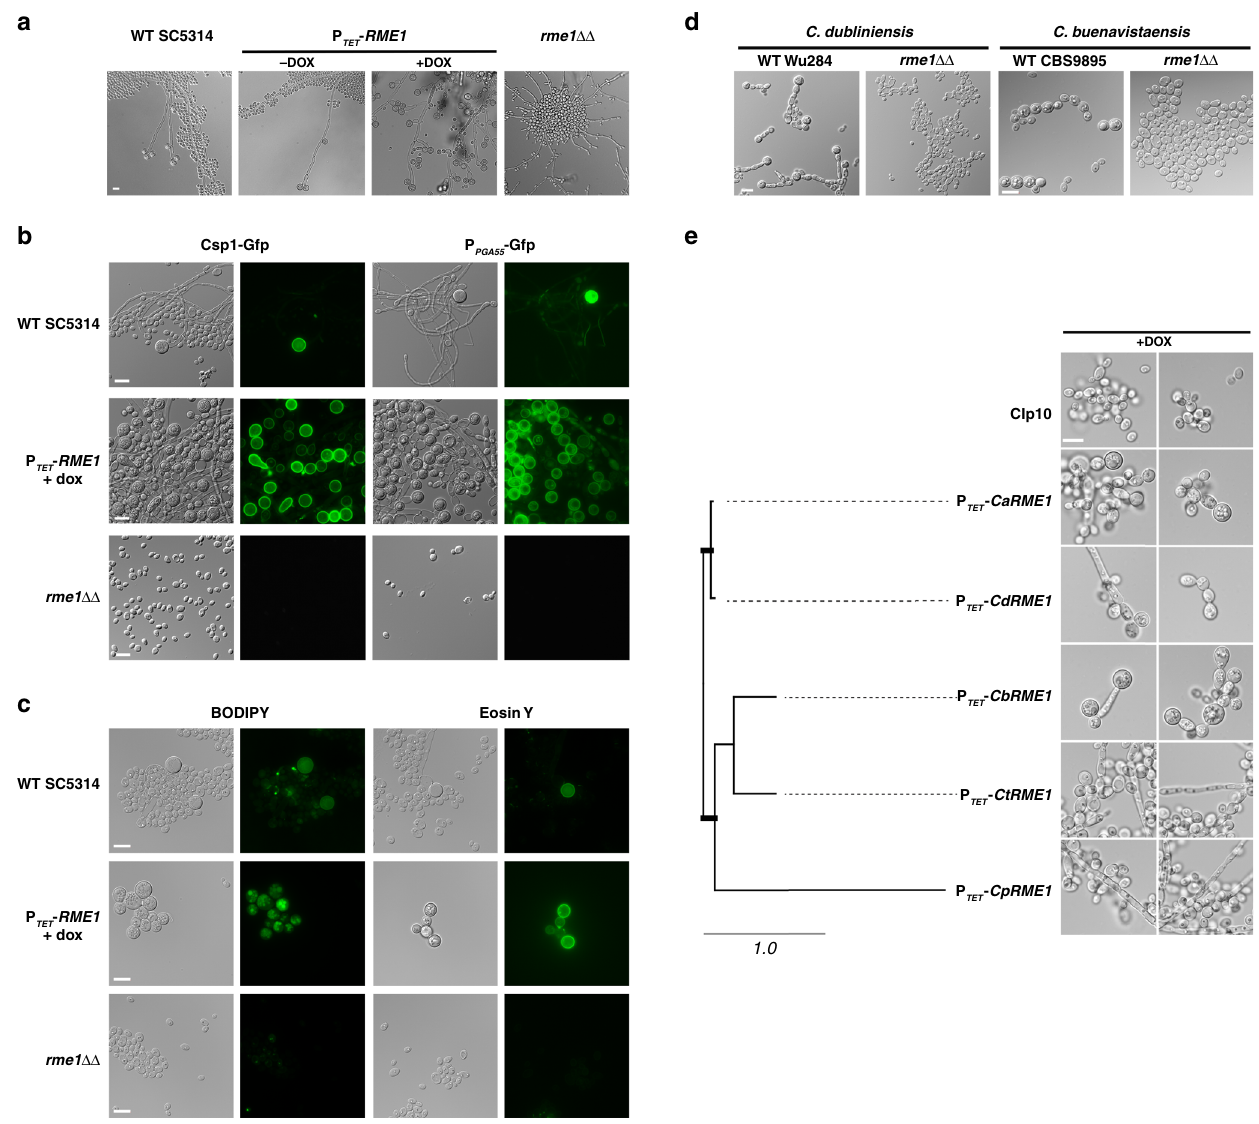
Fig. 2 RME1 controls chlamydospore formation. a C. albicans WT SC5314, P TET - RME1 (CEC5031) and rme1 ΔΔ (CEC4694) strains growing on PCB agar plates. Photomicrographs were taken after 3 days of incubation at 25 °C in the dark and under microaerophilic conditions. Scale bar = 10 μ m, applies to all pictures. b Both Csp1 and Pga55 expressions are dependent on Rme1. C. albicans WT SC5314, P TET - RME1 and rme1 ΔΔ strains expressing either the CSP1 - GFP or P PGA55 - GFP fusions (CEC4783, CEC4827, CEC4788, CEC4791, CEC4967 and CEC4804, respectively) were cultured on a cellophane fi lm covering PCB plates at 25 °C, in the dark and under microaerophilic conditions for 3 days. Cells were recovered from the cellophane fi lm and inspected by phase contrast and fl uorescence microscopy. Induction of Rme1 was achieved by adding doxycycline to the medium to a fi nal concentration of 40 μ g/mL. Scale bars = 10 μ m. c C. albicans WT SC5314, P ΔΔ (CEC4694) strains grown for 2 – 6 days in PCB medium supplemented with doxycycline TET - RME1 (CEC4741) and rme1 for inducing RME1 overexpression were incubated with BODIPY or Eosin Y. Scale bars = 10 μ m. d C. dubliniensis WT Wü284 and its rme1 ΔΔ derivative (left panels) and C. buenavistaensis CBS9895 and its rme1 ΔΔ derivative (right panels) were grown in PCB liquid medium at 25 °C, in the dark, during 24 h. Scale bars = 10 μ m. e C. albicans rme1 ΔΔ strains with conditional heterologous RME1 overexpression were grown overnight in liquid doxycycline-containing PCB, in the dark, at 25 °C. CaRME1: C. albicans, CdRME1: C. dubliniensis, CbRME1: C. buenavistaensis (all chlamydospore pro fi cient species), CtRME1 : C. tropicalis and CpRME1: C. parapsilosis (chlamydospore de fi cient species). Two representative fi elds are presented for each strain, all images are at the same scale. Scale bar = 10 μ m. The tree has been generated with PHYML 72 from a multiple alignment of Rme1 protein sequences done with MUSCLE 69 (Supplementary Fig. 3). Thick bars represent bootstrap supports >98% (bootstrap analysis of 100 resampled datasets); branch lengths are shown and the scale bar represents 1 substitution per